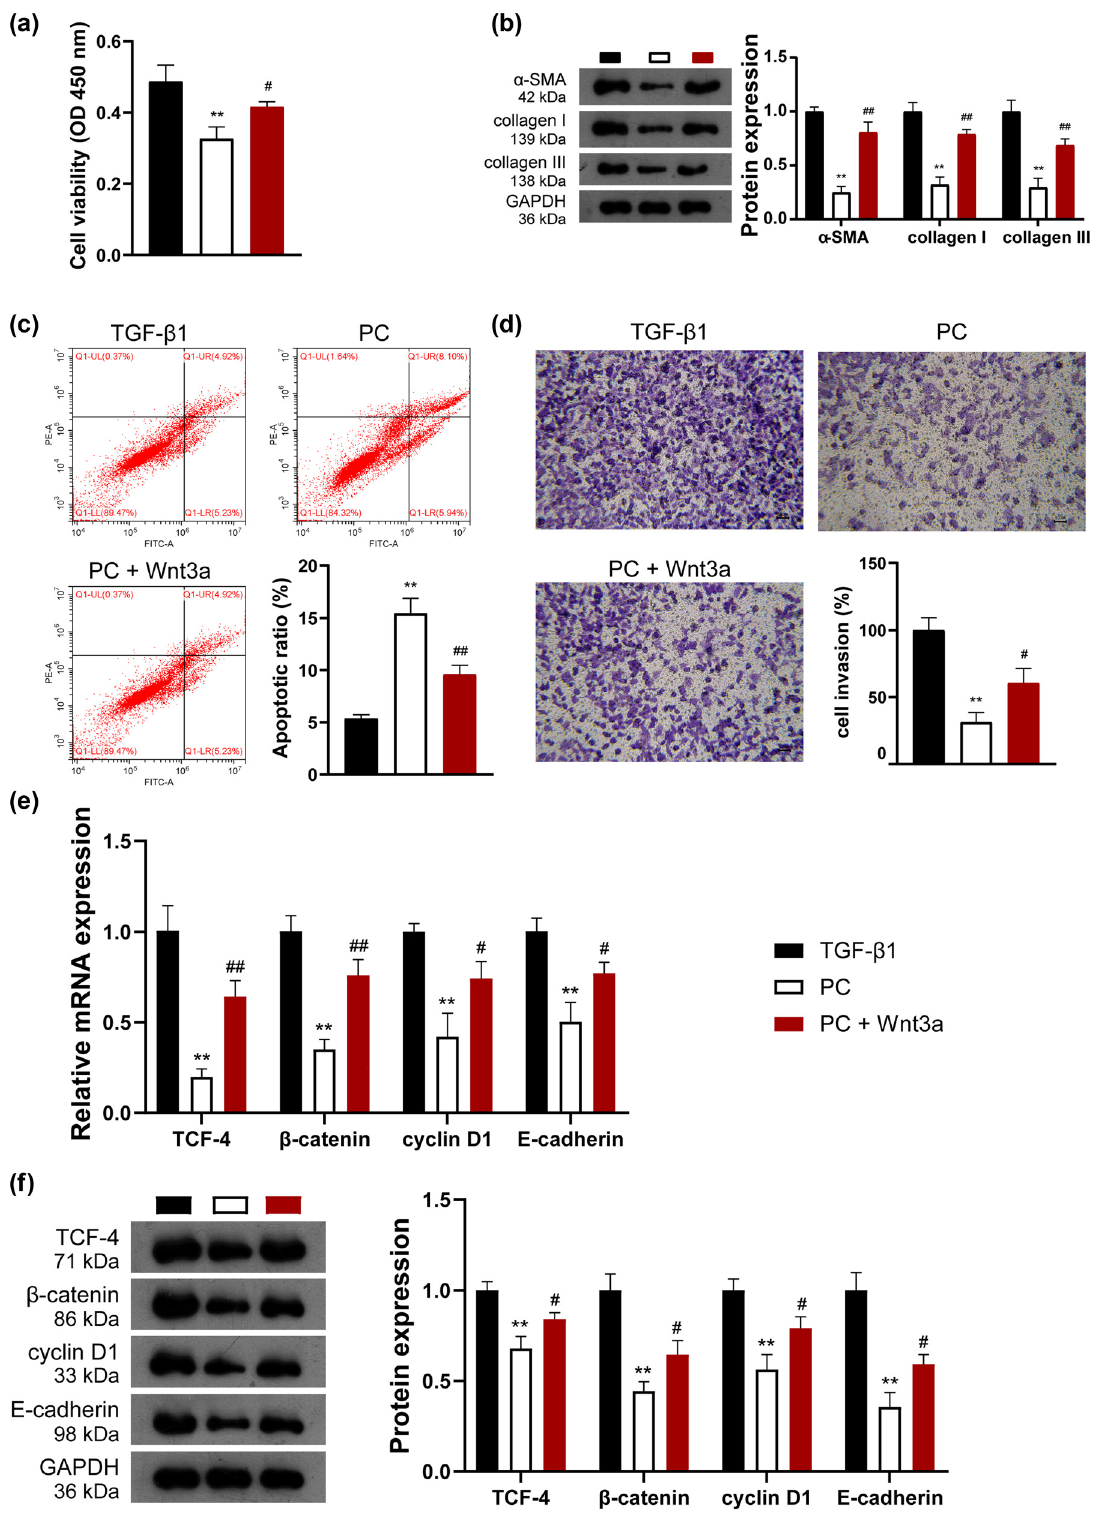
Figure 5: PC inhibits the activation of fi broblasts through inactivating Wnt/ β - catenin signaling pathway. ( a ) The proliferation of HFL - 1 cells was detected by CCK - 8 assay. ( b ) Cells ’ apoptosis was determined by fl ow cytometry assay. ( c ) The invasion of HFL - 1 cells was detected by transwell assay. ( d ) The expression of α - SMA, collagen I, and collagen III was examined by western blot. ( e and f ) The levels of TCF - 4, β - catenin, cyclin D1, and E - cadherin in HFL - 1 cells were detected by RT - qPCR and western blot assays. HFL - 1 cells were pre - treated with 100 ng/mL Wnt3a ( an activator of Wnt/ β - catenin signaling pathway ) for 30 min and cultured in the medium containing 20% prepared drug containing serum. ** P < 0.01 vs TGF - β 1, # P < 0.05 and ## P < 0.01 vs